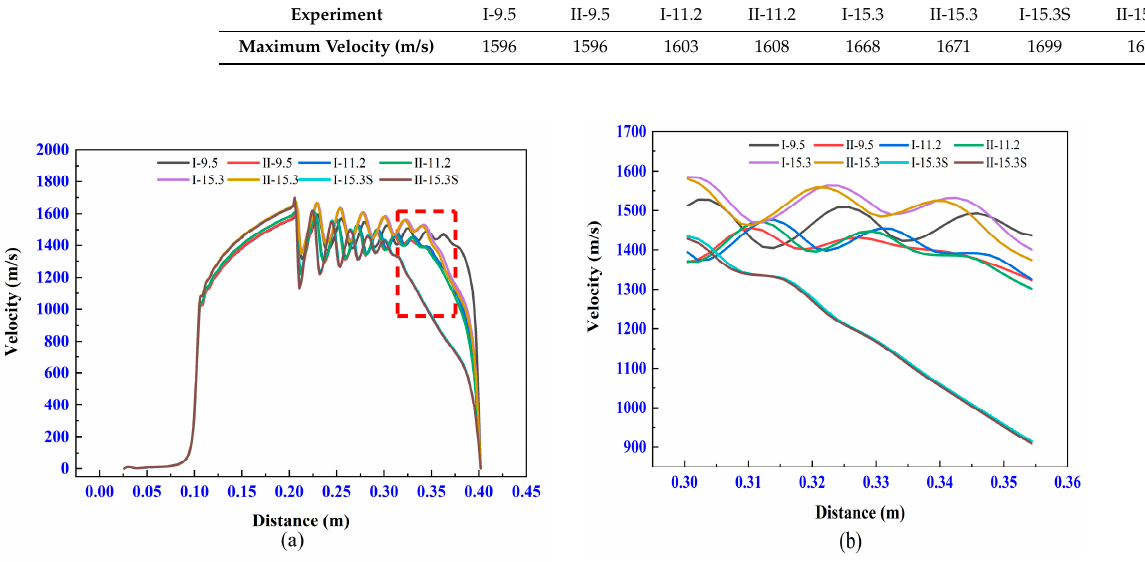
Figure 10. Velocity at the axis of the model ( a ) and a partially enlarged view of the red areas ( b ). Table 3. Maximum velocity corresponding to different experimental